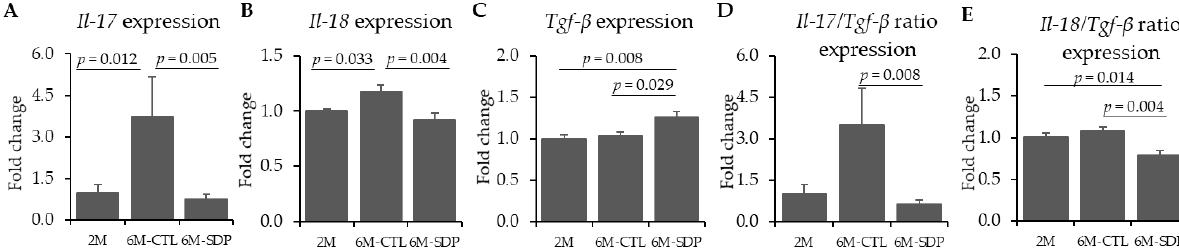
Figure 4. Effect of SDP supplementation on cytokine gene expression. Panels ( A – C ) show the gene expression of Il-17 , Il-18 , and Tgf-β in cortex tissue, respectively. Panels ( D , E ) show the gene expression ratio Il- 17/ Tgf-β and Il- 18/ Tgf-β in cortex tissue, respectively. Results are expressed as mean ± SEM ( n = 5–6 mice). Statistics: one-way ANOVA followed by Fisher’s multiple comparison test. Il: interleukin; Tgf-β: transforming growth factor beta.